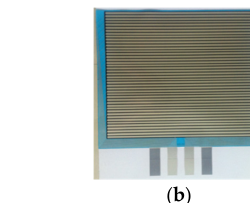
Figure 2. The matrix pressure sensor: ( a ) Column side; ( b ) Row side. (Reprinted with permission from Ref. [12] Copyright 2020 IEEE).